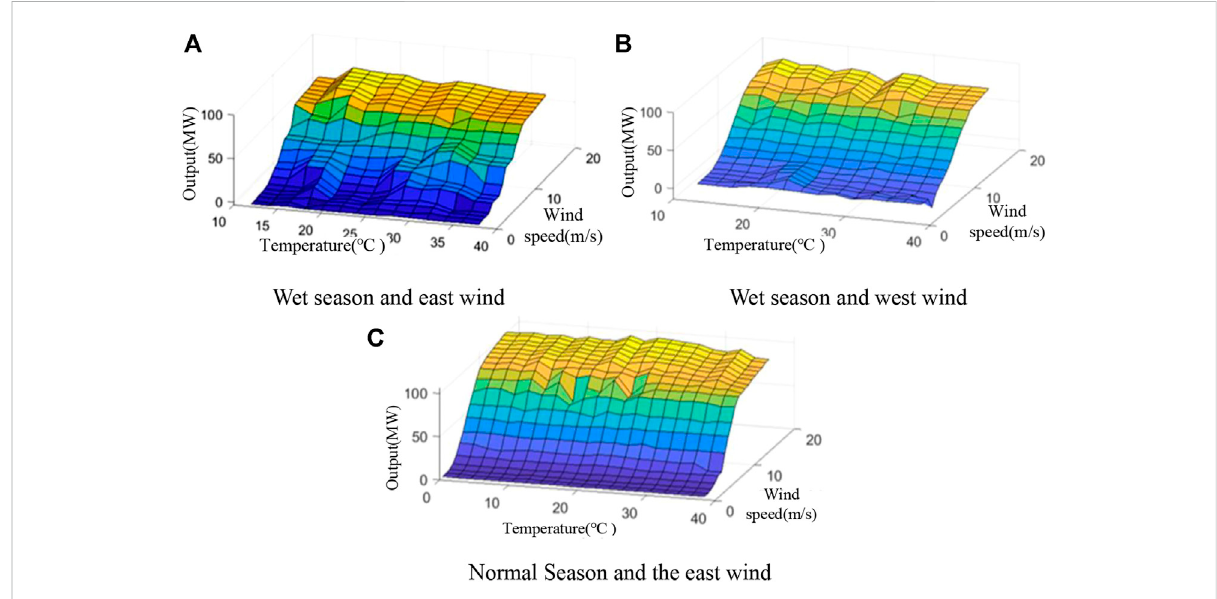
FIGURE 5 Windspeed – temperature – outputdistributiondiagramofthewindpowerstationacrossperiodsunderdifferentwinddirections. (A) Wetseason and east wind. (B) Wet season and west wind. (C) Normal Season and the east wind.